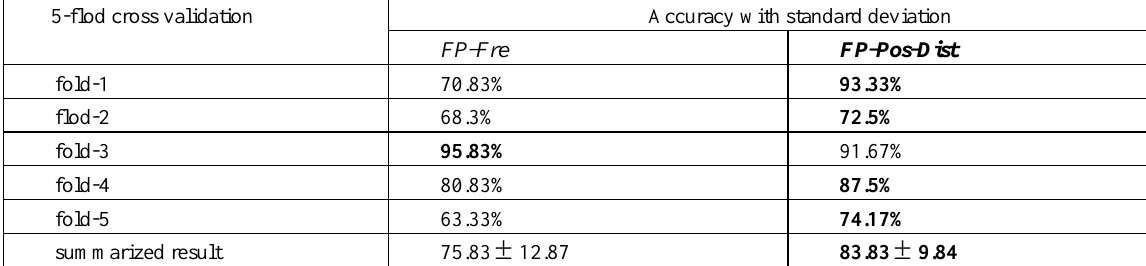
Table 9. Experiments 2: comparison results on tot_info dataset 5-flod cross